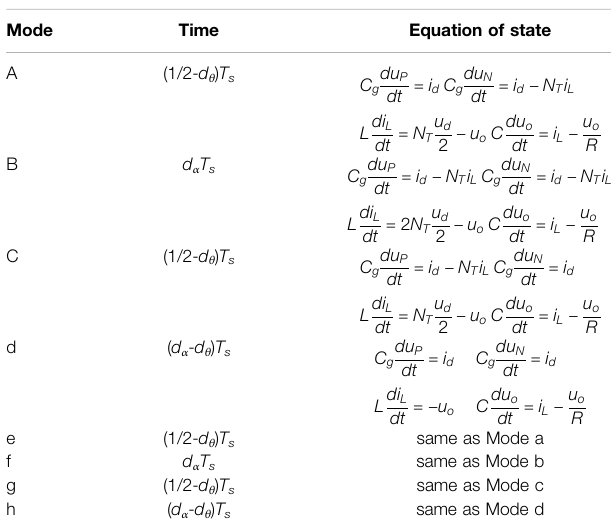
TABLE 1 | The equation of state for the